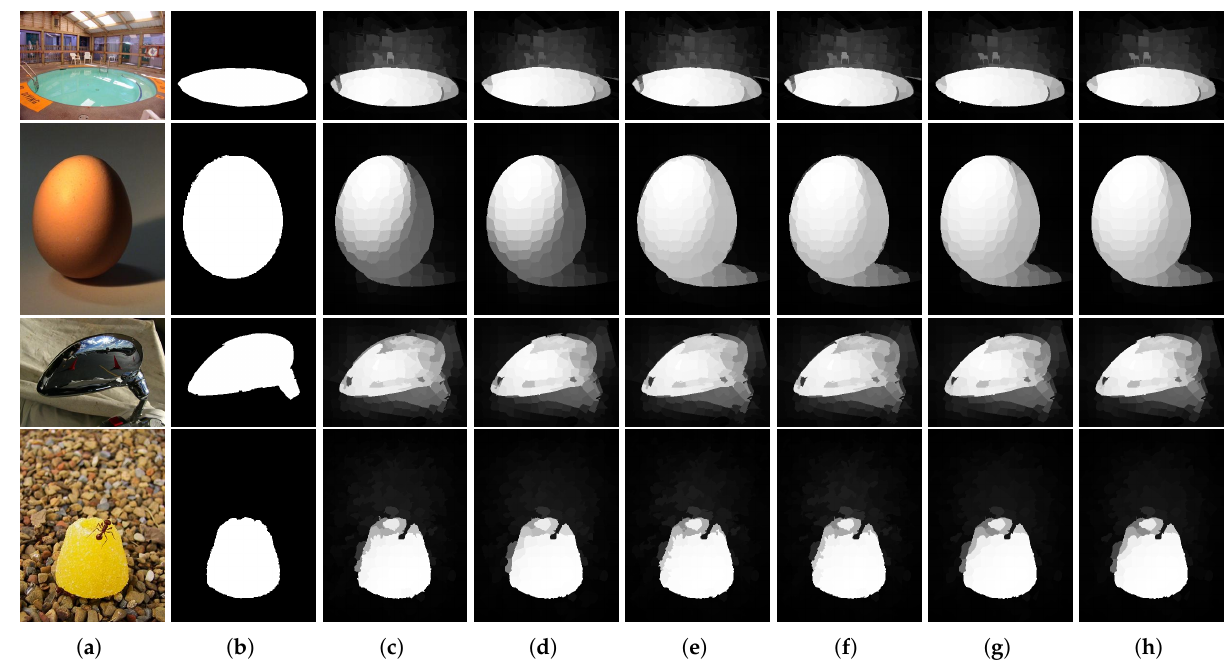
Figure 4. Visual comparison for MC [45]. ( a ) Input images; ( b ) ground truth; ( c ) results of MC; ( d ) BF; ( e ) ODOG; ( f ) LODOG; ( g ) BF+ODOG; ( h ) BF+LODOG.